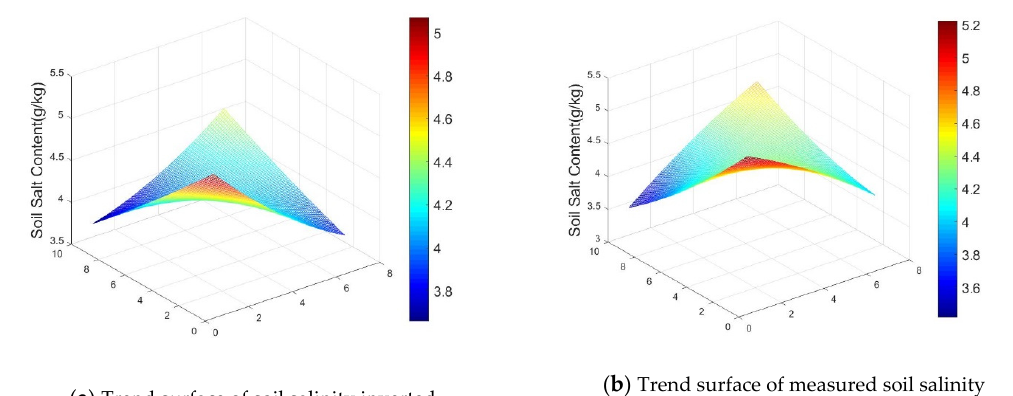
Figure 5. Soil salinity trend surface of test area A.